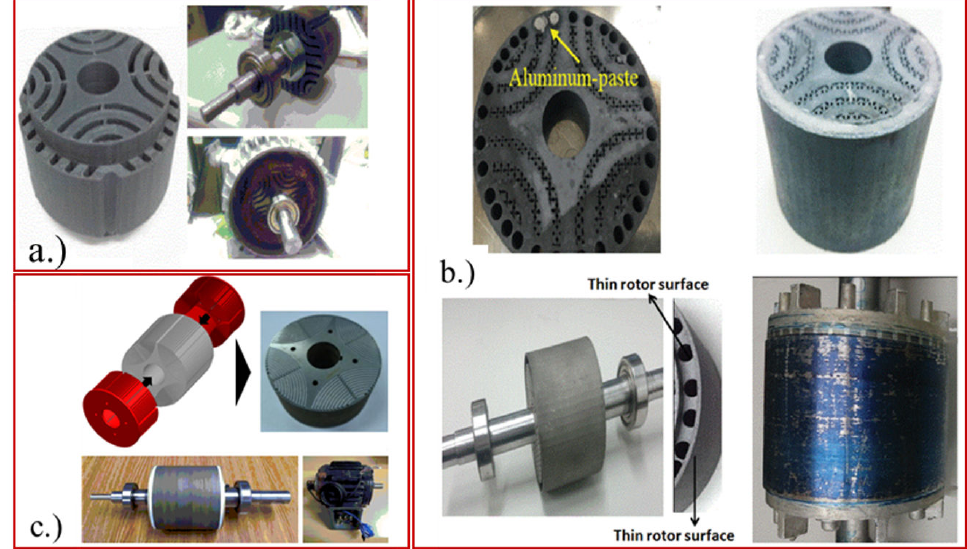
Figure 12. AM-built rotors for SynRM ( a ) 3D printed prototype [106] ( b ) Prototype Line Start-SynRM (LS-SynRM) with 3d-Net structure in rotor [107] ( c ) Prototype rotor design, assembled rotor and SynRM